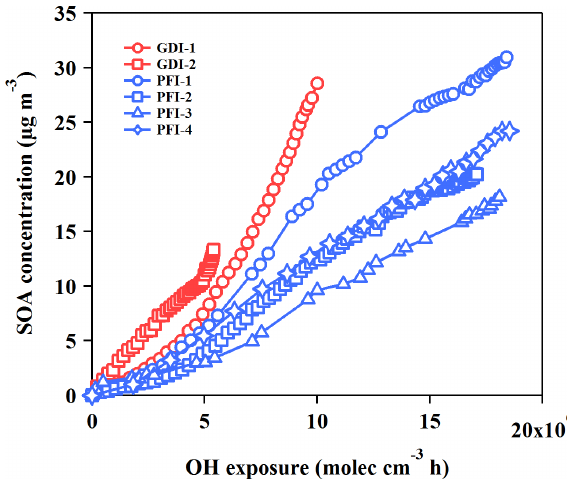
Figure 4. SOA productions from the GDI vehicle exhaust (red markers) and the PFI vehicle exhaust (blue markers) as functions of OH exposure in the chamber